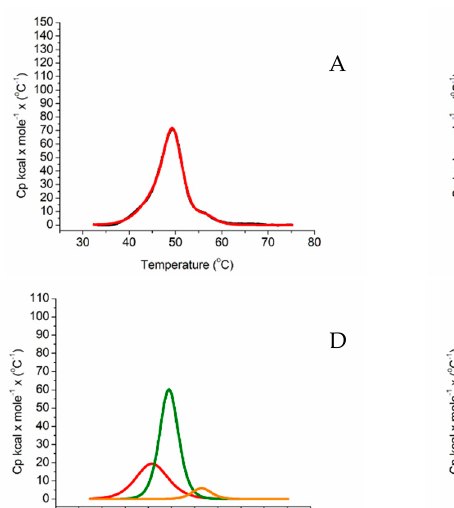
Figure 2. Thermograms of ( A ) aromatase, ( B ) CYP3A4, and ( C ) BMR. All measurements were carried out at scan/rate of 90 ◦ C/h. Black lines are the experimental curves, the red line is the fitting of the experimental curve applying a non-two-state denaturation model. ( D ) Deconvolution BMR. The green line is the deconvolution of the first peak and the orange line is the deconvolution of the second peak.